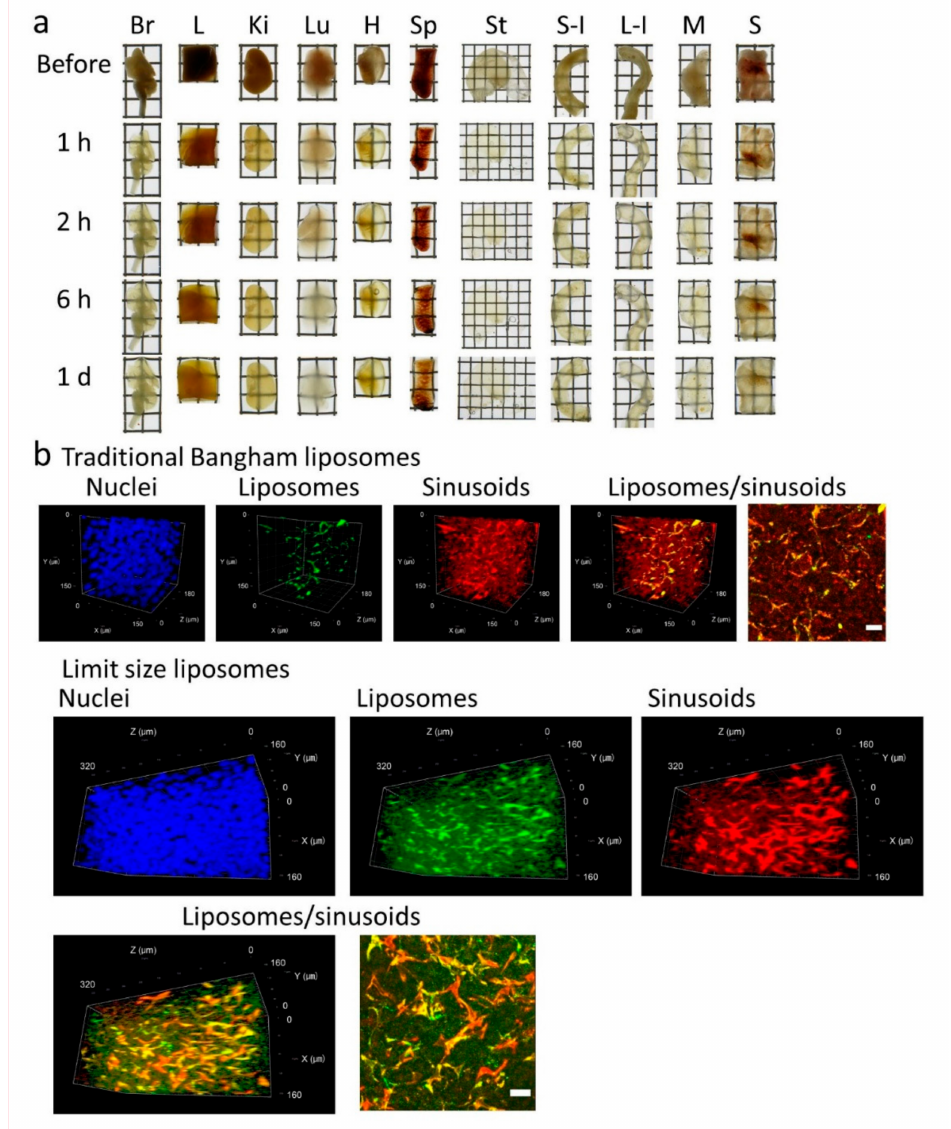
Figure 6. Seebest-PP performance. Seebest-PP solution comprising 8 M urea and 20 w / v % propylene oxide-denatured PEI was used. ( a ) Before and at 1, 2, and 6 h, and 1 day after immersion in Seebest, tissues were observed. Br, brain; L, liver; Ki, kidney; Lu, lung; H, heart; Sp, spleen; St, stomach; S-I, small intestine; L-I, large intestine; M, muscle; S, skin. Each lattice was 4 mm wide and 4 mm high. ( b ) Visualization of the spatial distribution of liposomes in the liver. DiO-labelled traditional Bangham liposomes or limit size liposomes were intravenously injected into mice. DiI was also intravenously injected at 1.5 h after liposome injection. Thirty minutes after DiI injection, the liver specimens were subjected to confocal microscopy. Fluorescence images were acquired as a z-stack at 1.090- µ m intervals using a confocal microscope with a × 25 LD LCI Plan-Apochromat objective lens. Acquisition settings were as follows: zoom, 2.0; xy scaling, 0.664 µ m; spectral emission filters (bandwidth), 409–484, 494–543, and 550–670 nm; laser wavelengths, 405, 488, and 543 nm for DAPI, DiO, and DiI, respectively. Maximum intensity projections of liposomes / sinusoids were also presented. Scale bars represent 20 µ m. Each image was representative of three